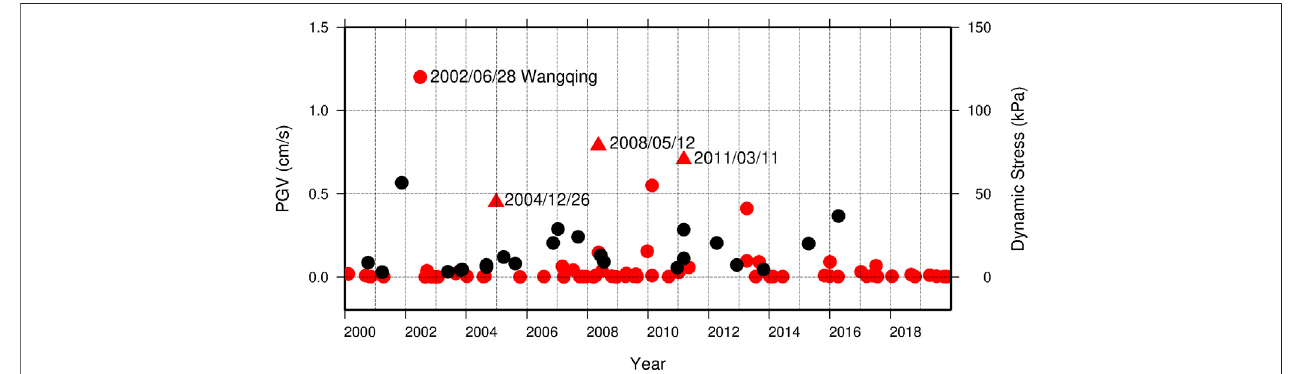
FIGURE 6 | PGV and dynamic stress of deep-focus earthquakes and large distant earthquakes. Red circles represent deep-focus earthquakes within 500 km. Black circles represent large distant earthquakes beyond 1000 km. Three large distant earthquakes (2004 M 9.3 Sumatra, 2008 M 7.9 Wenchuan, and 2011 M 9.1 Tohoku-Oki earthquakes) that dynamically triggered micro-seismicity in Changbaishan volcano are marked by red triangles (Liu et al., 2017).